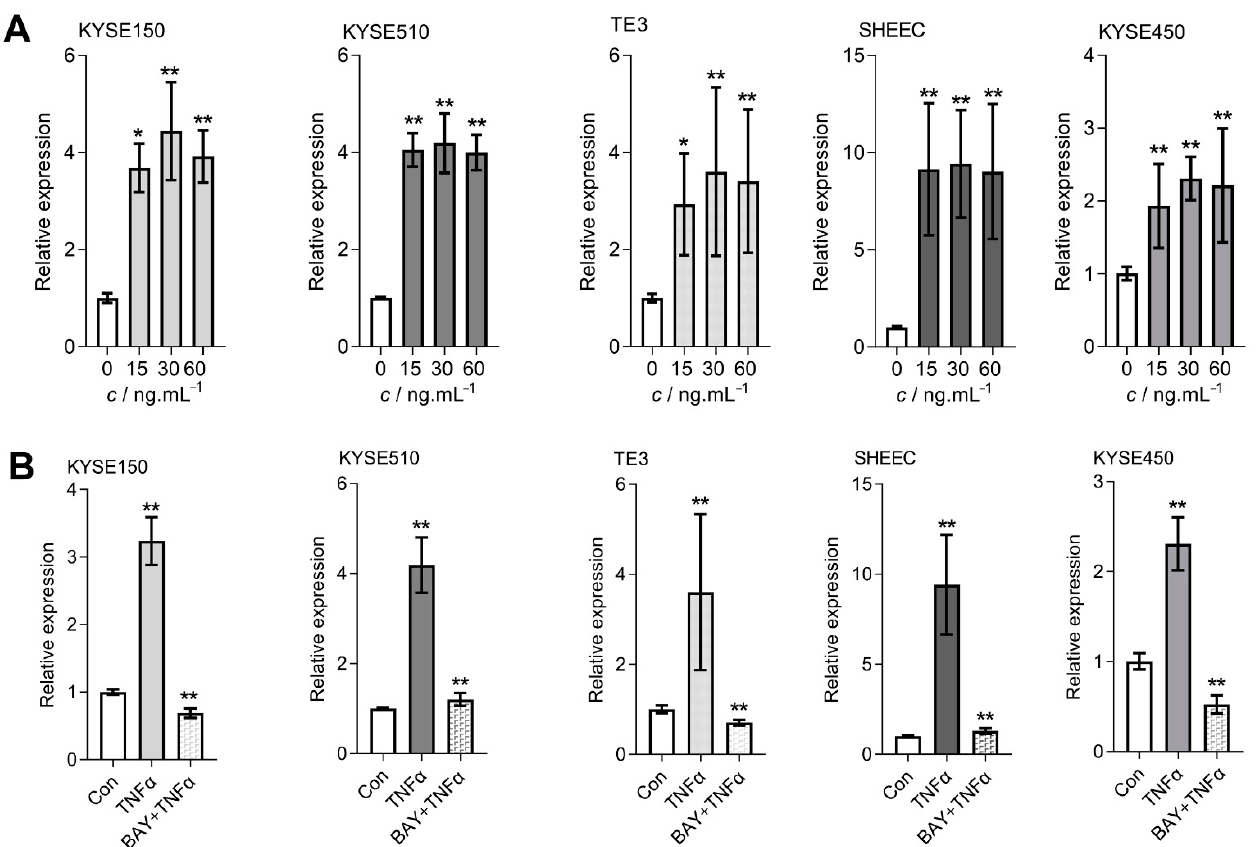
Figure 3. BIRC3 up-regulated by TNF α . Relative expression of BIRC3 gene in different concentrations of TNF α -treated cells ( A ) and 50 µ mol/L Bay 11-7082 and 30 ng/mL TNF α combined treated cells ( B ). The mRNA relative expression of BIRC3 was normalized to that of the housekeeping gene GAPDH . The data were presented as the means ± SD, * and ** indicate p < 0.05 and p < 0.01, analyzed according to one-way ANOVA, respectively.